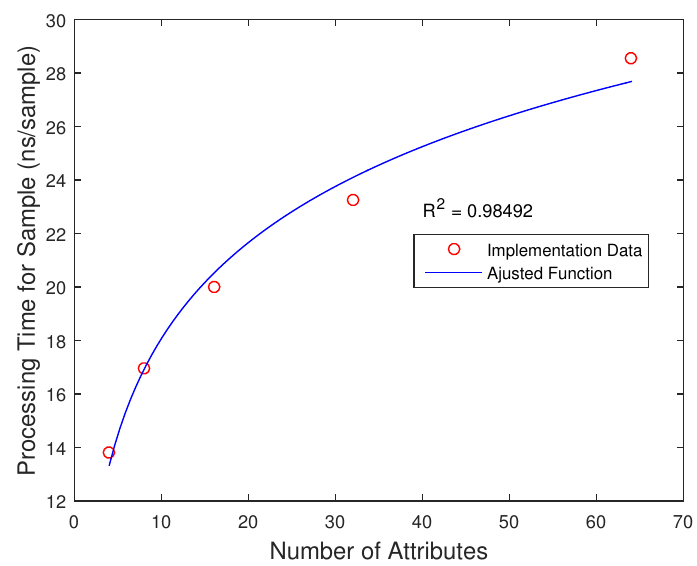
Figure 11. Processing time function adjusted by a logarithmic function.